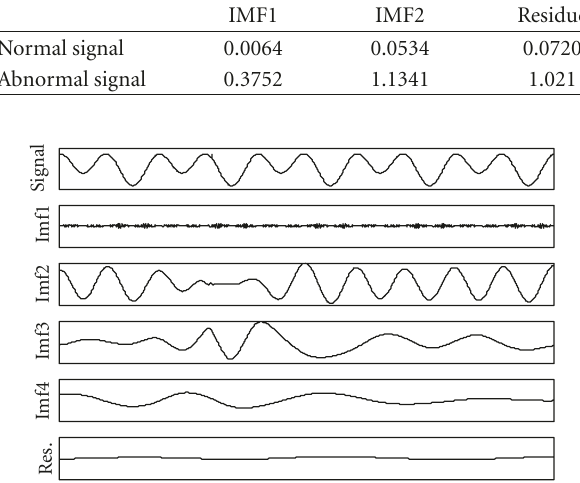
Figure 2: EMD result of signal after tradition doing wavelet